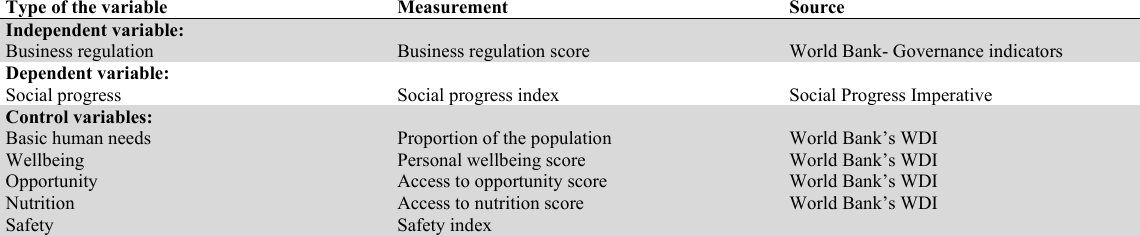
Variables and measurement of variables Type of the variable